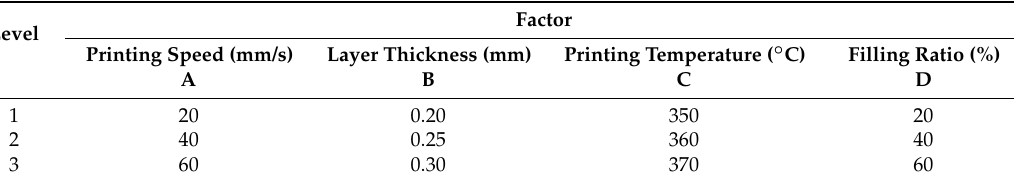
Figure 1. Schematic of customized polyether-ether-ketone (PEEK) fused deposition modeling (FDM) system. Table 1. Orthogonal factor level table for PEEK FDM.